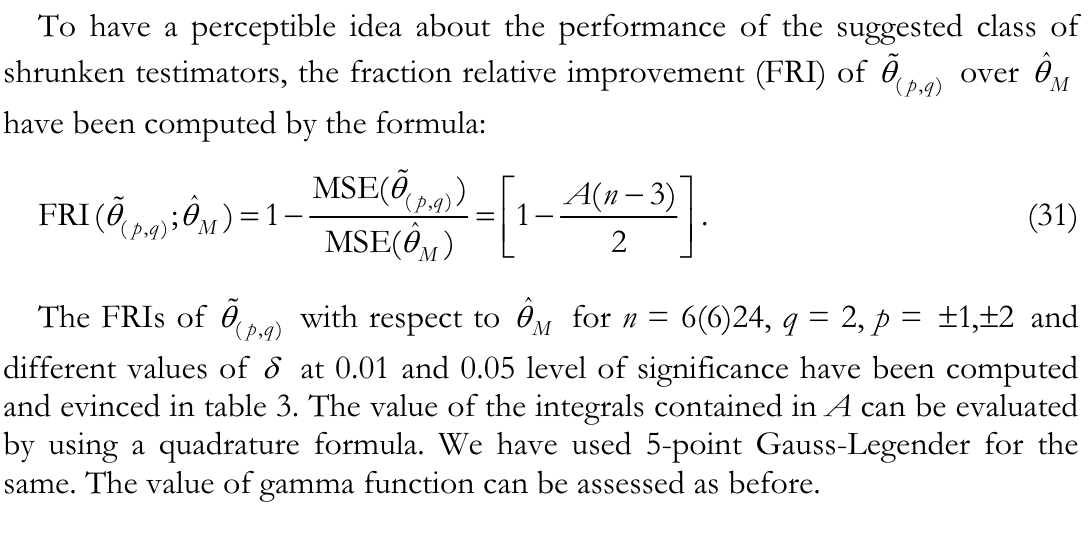
Fraction Relative Improvement of